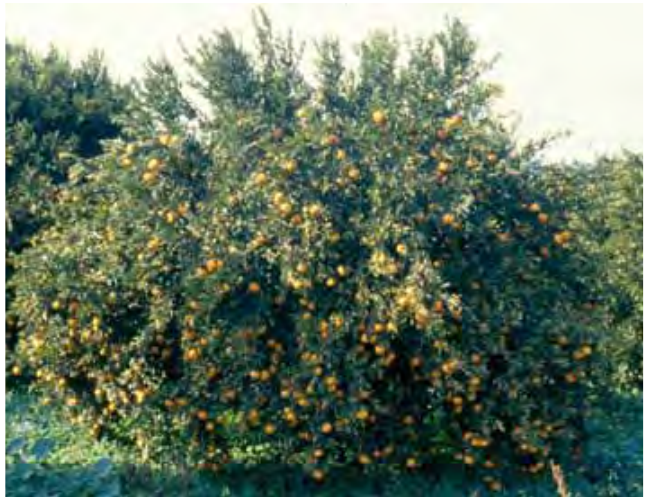
Fig. 4 - ‘Avana’ mandarin